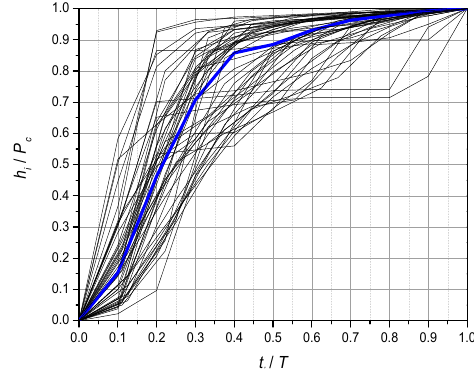
Figure 4. Mass curves for 51 short duration rainfall with the median for Wroc ł aw.